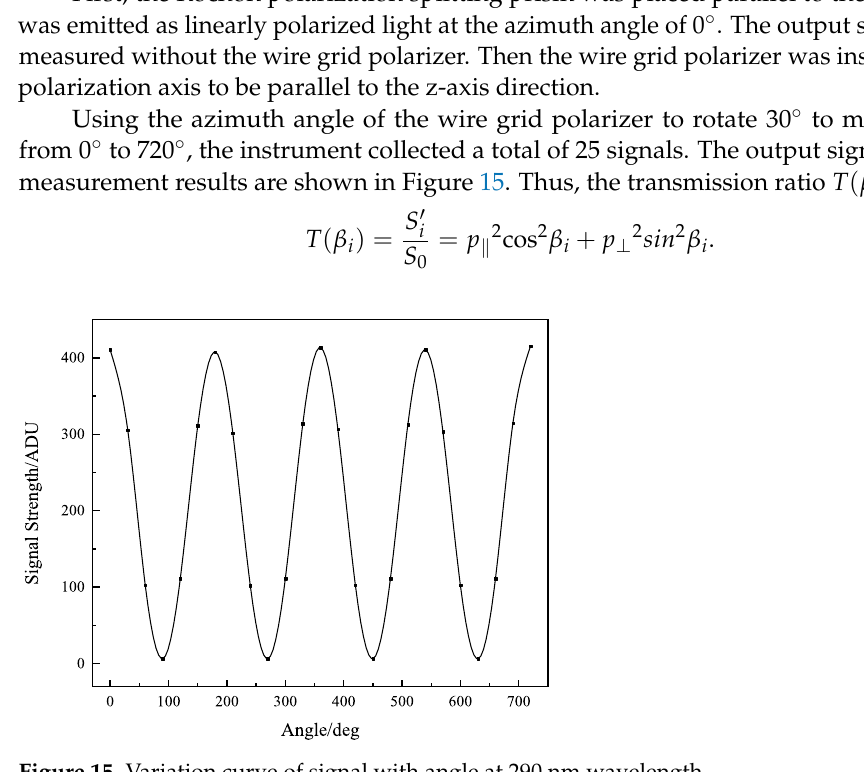
Figure 15. Variation curve of signal with angle at 290 nm